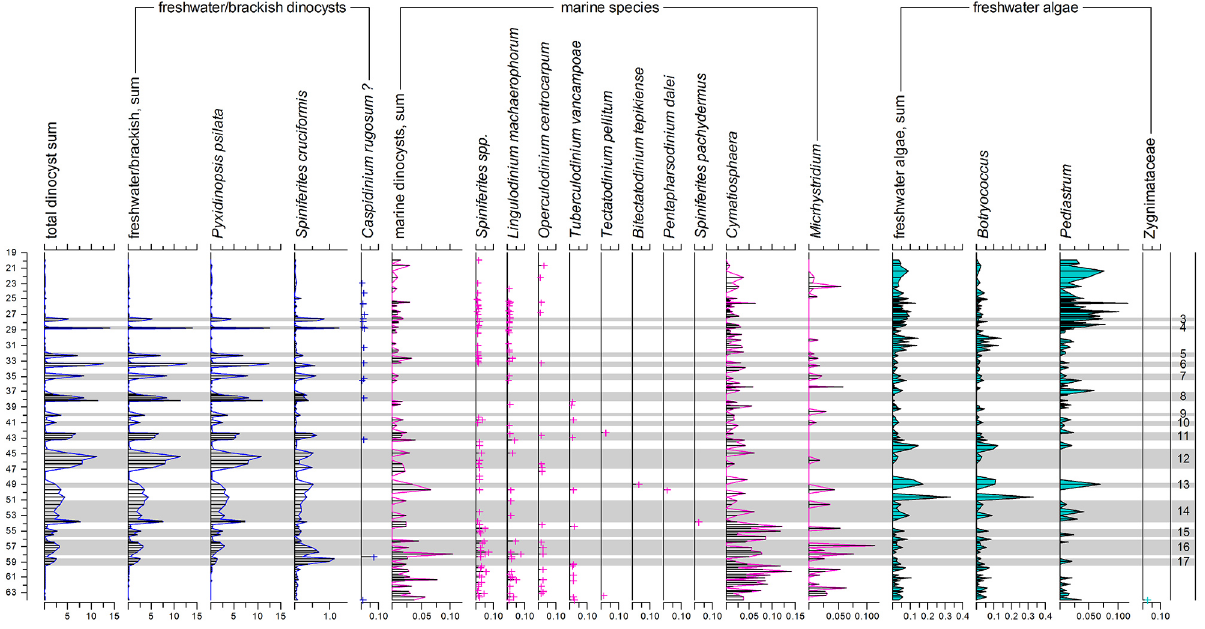
www.clim-past.net/10/939/2014/ Clim. Past, 10, 939–954,